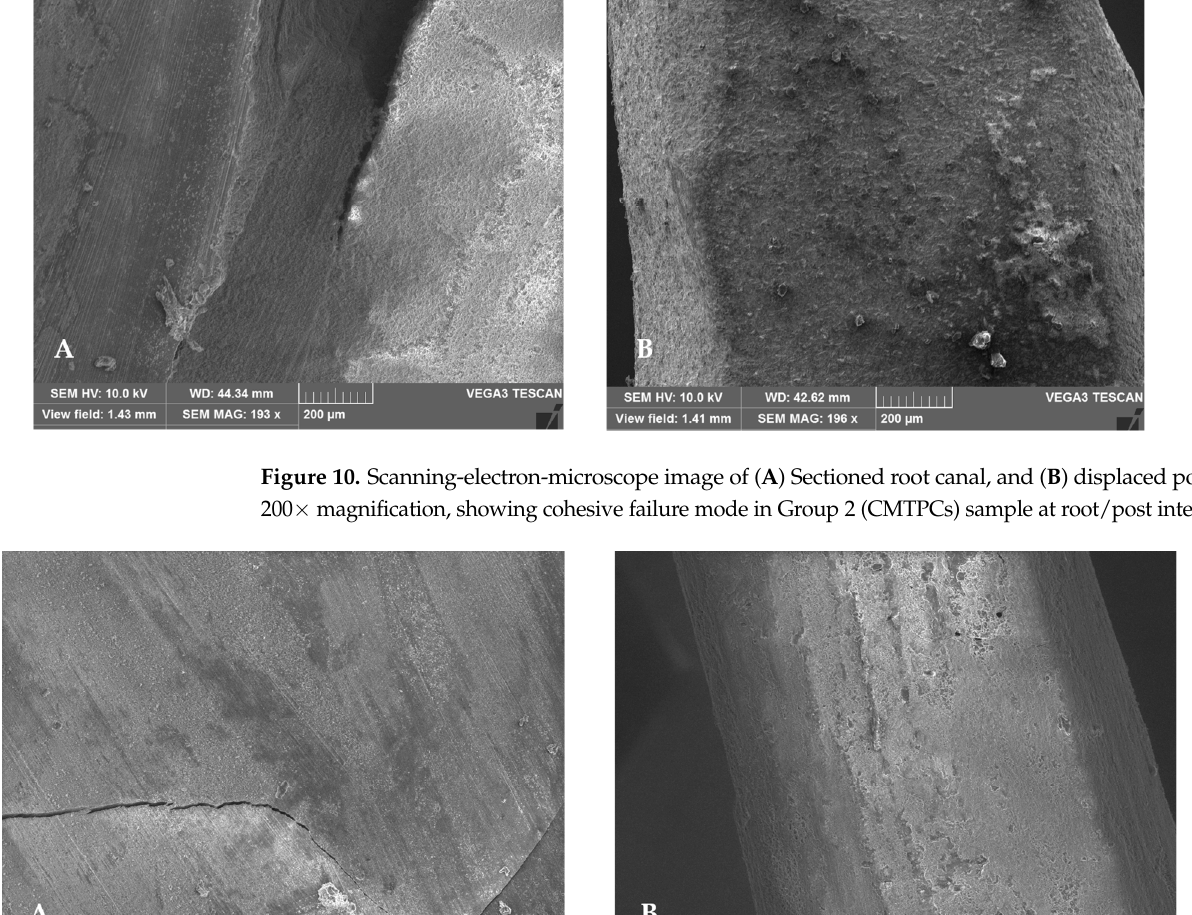
Figure 12. Scanning-electron-microscope image of ( A ) Sectioned root canal, and ( B ) displaced post, at 200× magnification, showing cohesive failure mode in Group 4 (CMZPCs) sample at root/post interface. 4. Discussion This study evaluated the differences in the retention of different types of custom post and cores. Significant differences in retention were observed when the groups were com- pared. Therefore, the tested null hypothesis could be rejected; however, retention varied according to the fabrication technique and material used for manufacturing custom post and cores. Several studies have reported acceptable clinical outcomes with CCNPPCs, which have been used for many years; hence, they were used as the control group in this study [2,4–8,18]. Advancements in materials science and the use of CAD/CAM have transformed the approach to fabricating indirect restorations in the field of prosthodontics, including the fabrication of custom post and cores. These new materials are easier to fabricate when compared with non-precious alloys. The current literature lacks evidence to support that